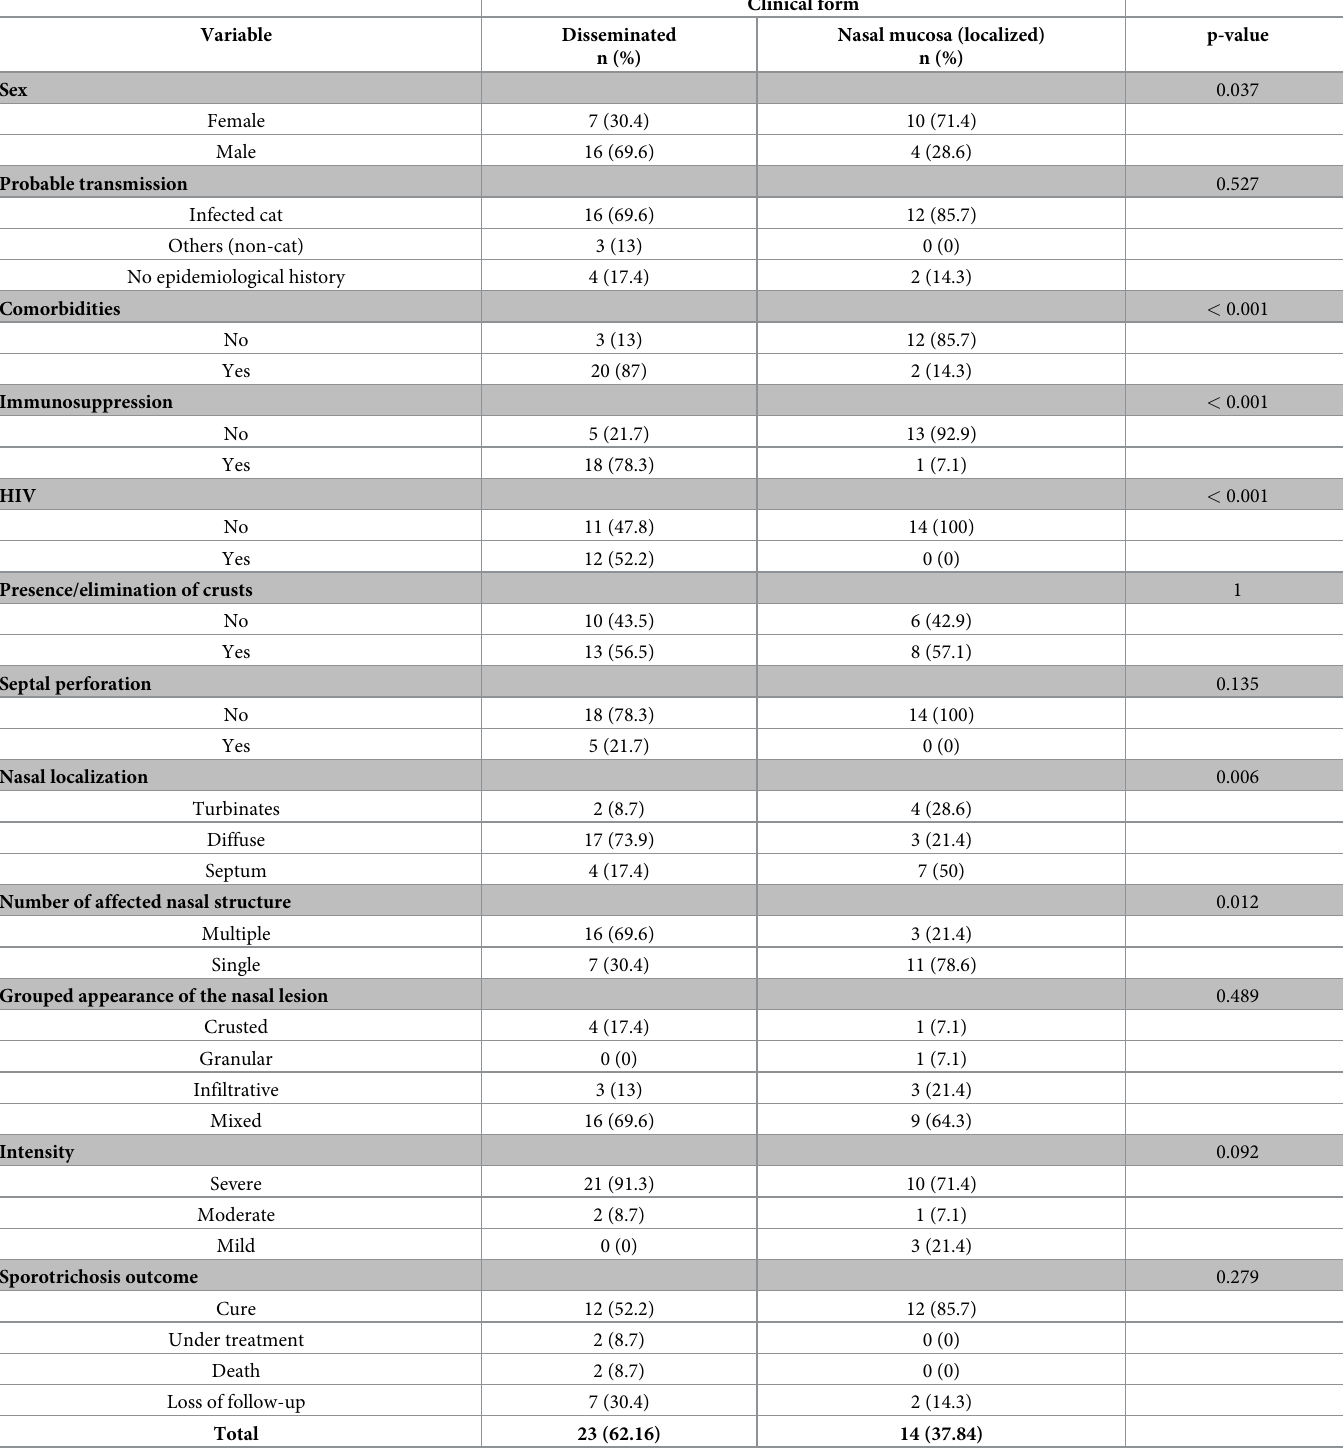
Table 3. Association of selected variables with the clinical form of 37 cases of sporotrichosis in the nasal mucosa treated at the ENT outpatient clinic at the INI/FIO- CRUZ